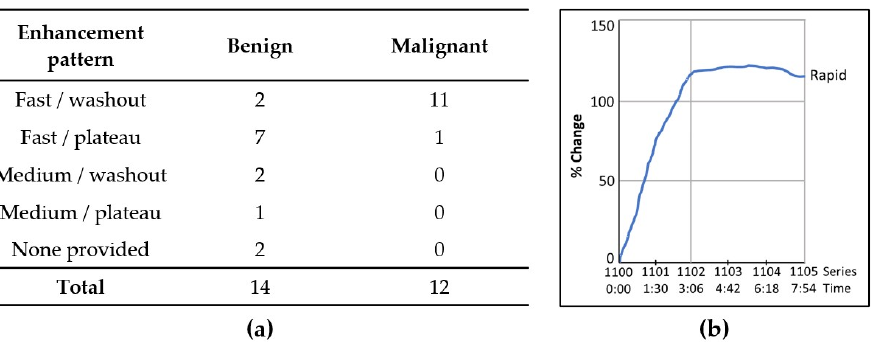
Figure 3. Enhancement pattern of benign and malignant lesions. ( a ) Enhancement patters are de- fined as: “Fast/washout” (fast initial enhancement with washout on delayed sequences); “Fast/plateau” (fast initial enhancement with plateau on delayed sequences); “Medium/washout” (medium initial enhancement with washout on delayed sequences); “Medium/plateau” (medium initial enhancement with washout on delayed sequences); “None provided” (no kinetic assessment was provided in the report). ( b ) Representative graph of a benign lesion showing fast initial enhancement with plateau on delayed sequences.